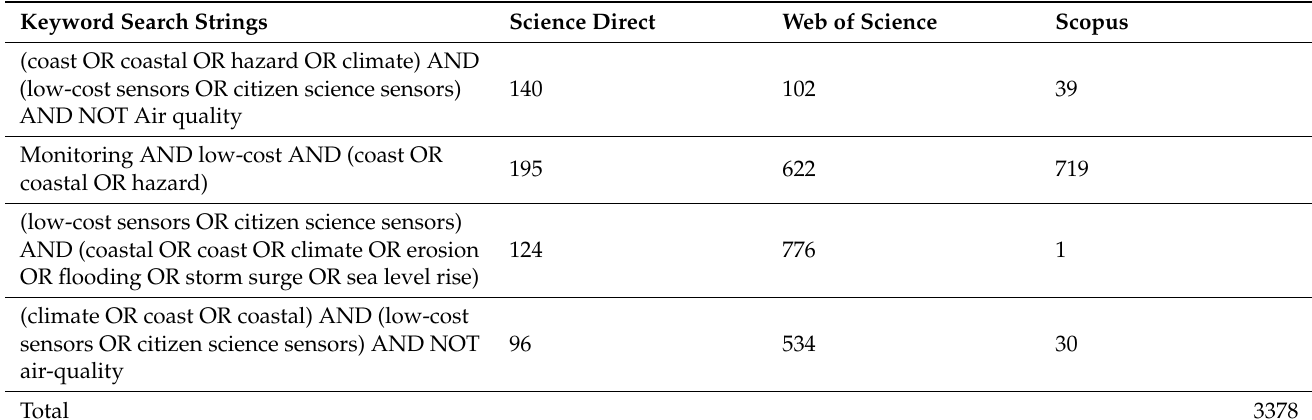
Table 1. Combination of keywords for retrieving relevant articles from three scientific databases (Web of Science, ScienceDirect, Scopus).